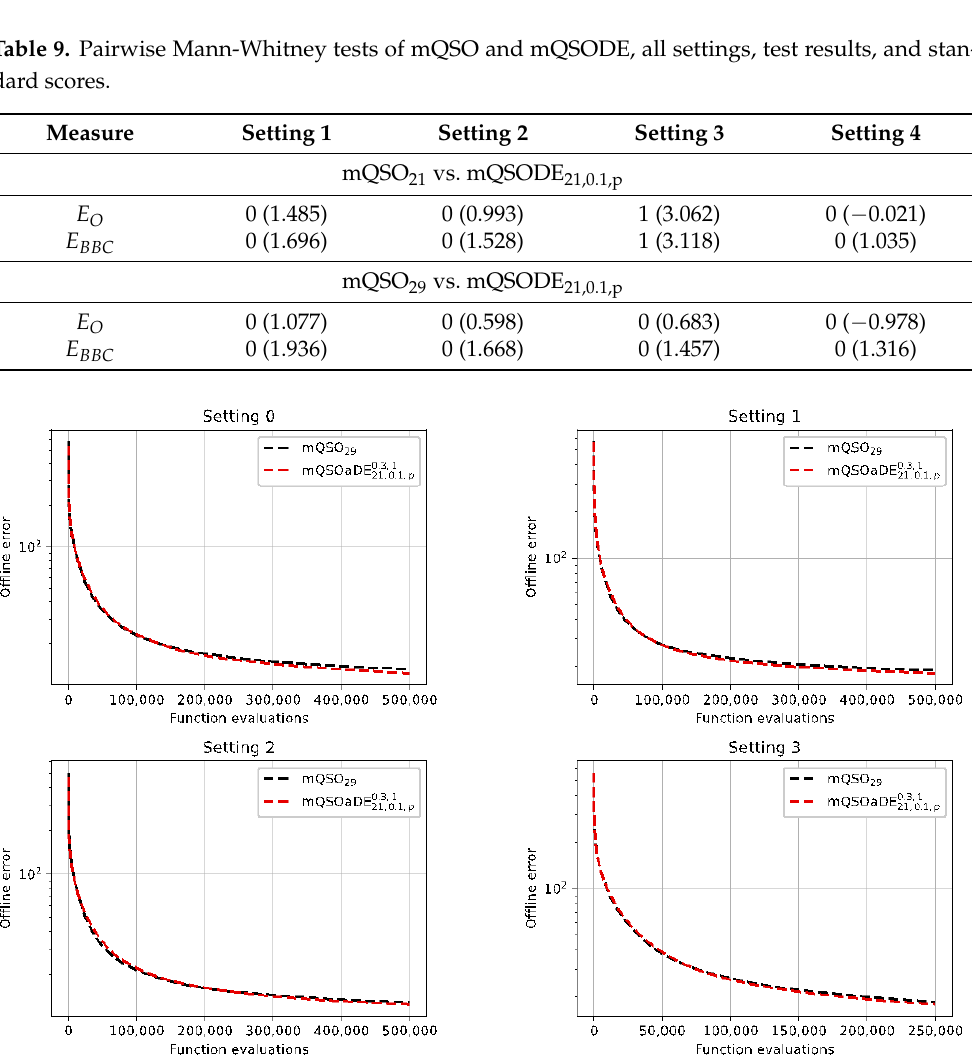
Figure 3. Offline error graphs of three tested algorithms with two benchmark cases: 2000 and 5000 function evaluations between changes.